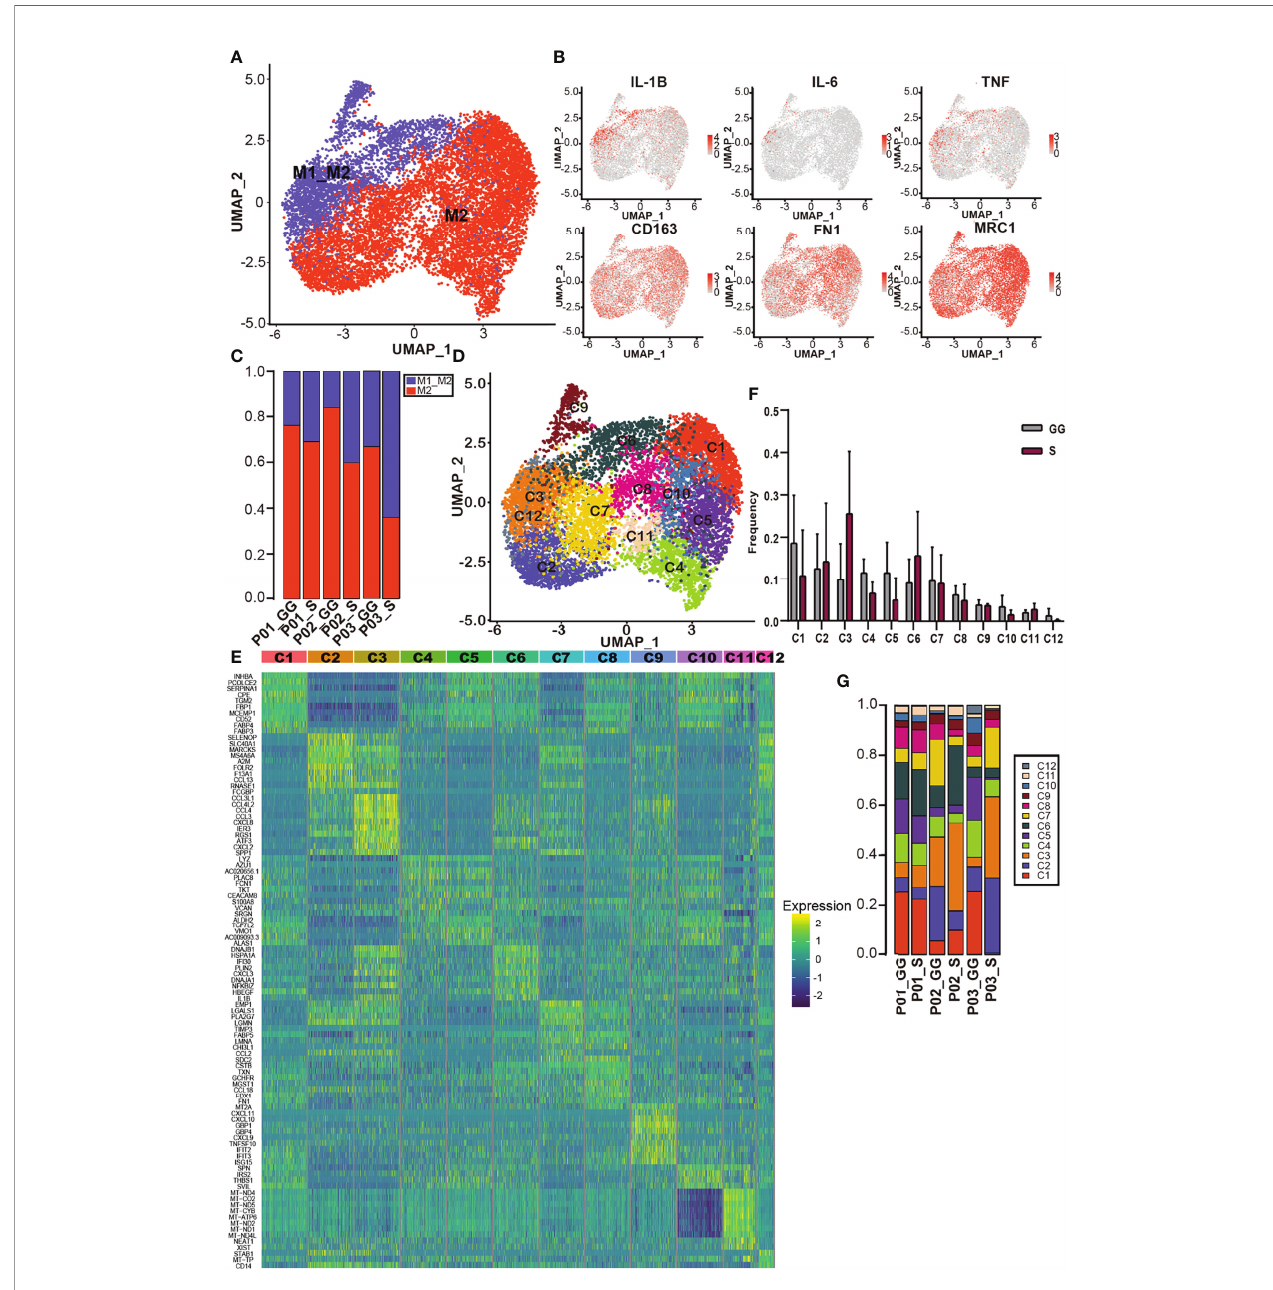
FIGURE 4 | Diversity of macrophages within different components in mGGO. (A) The UMAP of M1_M2 macrophages (blue) and M2 macrophages (red) distribution. (B) The UMAP shows expression patterns of M1 macrophage markers IL-1B, IL-6, and TNF and M2 macrophage markers CD163, FN1, and MRC1. (C) Proportions of M1_M2 macrophage (blue) and M2 macrophage (red) in different samples. (D) The UMAP visualized 12 macrophage subclusters. (E) The heatmap reveals distinct transcription patterns among macrophage subclusters; each row represents a gene, and each column represents a macrophage. (F) Proportions of 12 macrophage subclusters (x-axis) reveal distinct distributions between GG component (gray) and S component (red) in mGGO. (G) Proportions of macrophage subclusters in different samples. mGGO, mixed ground-glass opacity; UMAP, Uniform Manifold Approximation and Projection; GG, ground glass; S,